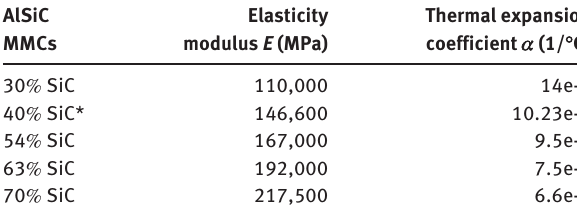
Table 2 Mechanical properties of AlSiC MMC (MatWeb). *Values are estimated.